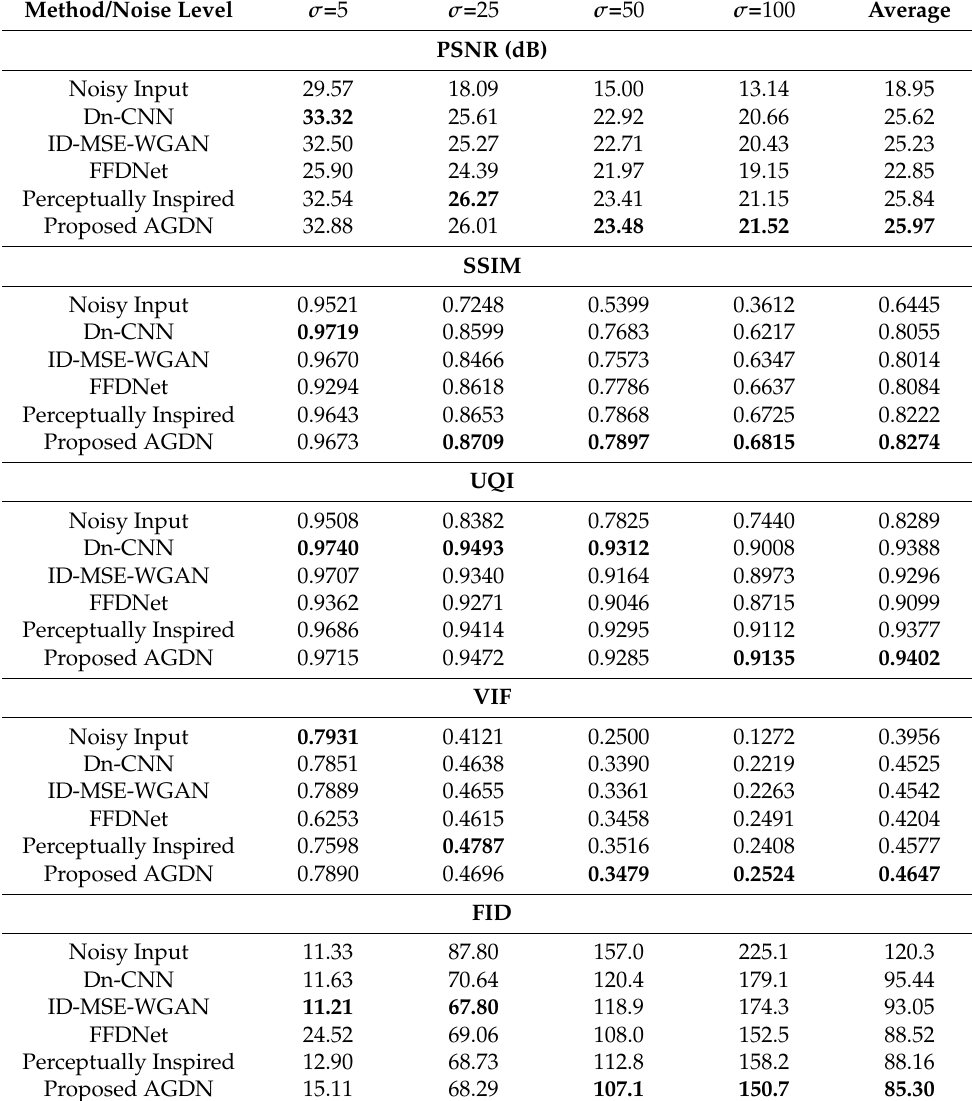
Table 10. Quantitative results of baseline methods with the proposed method on the DIV2K dataset of multiple noise levels. Bold results show good